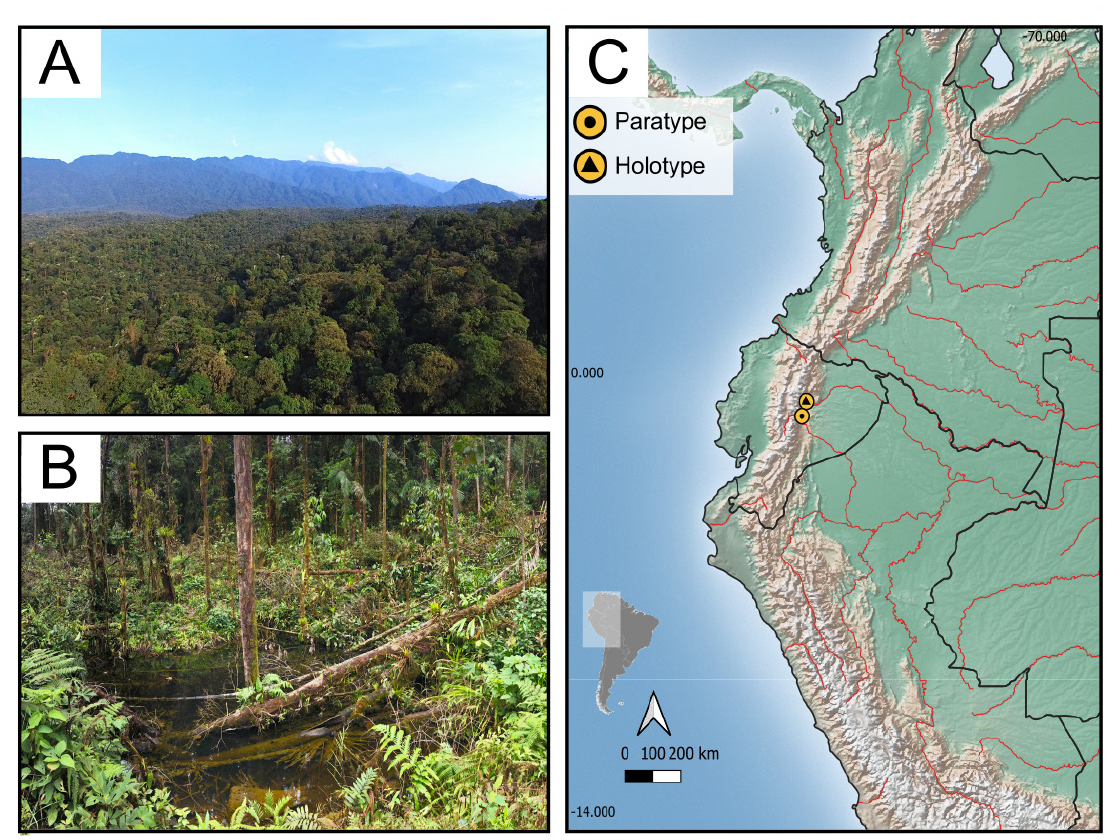
Fig. 18. Habitat and geographic range of Tropidophis cacuangoae sp. nov. A . Overview of Eastern Piedmont Evergreen Forest habitat. B . Collection site of T . cacuangoae sp. nov. paratype (DHMECN 15893). C . Geographic distribution of T . cacuangoae sp. nov. in